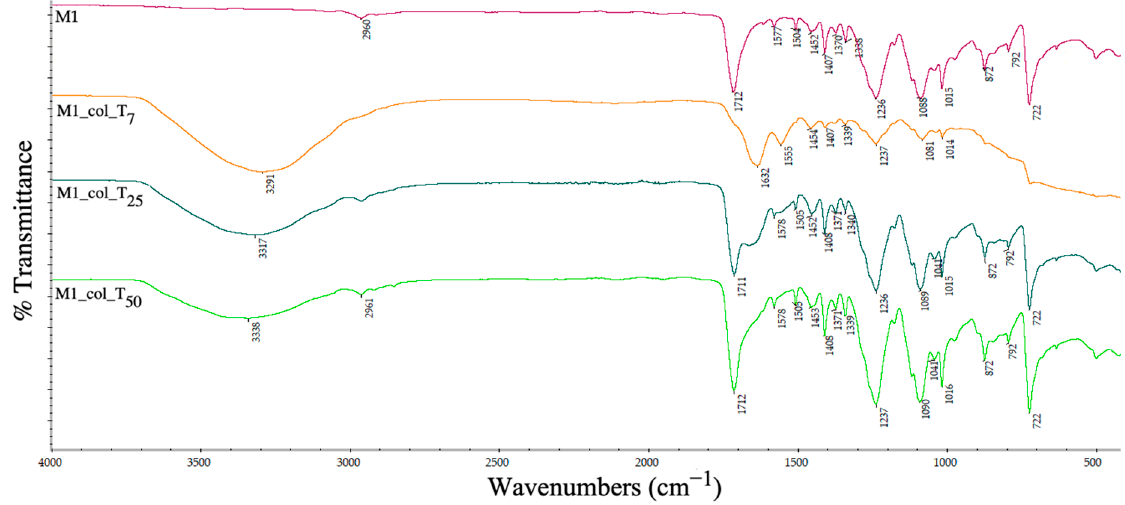
Figure 19. ATR spectra of PET pellets before and after collagen deposition at days 7 (T 7 ), 25 (T 25 ) and 50 (T 50 ).